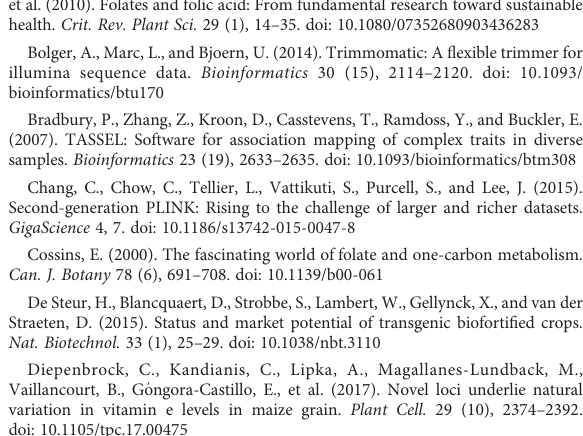
SUPPLEMENTARY FIGURE 5 Amino acid sequence alignment of ZmFCL and its orthologs in various species. Zm0001d13786 (B73), Zm0001d13786 (RC), SORBI_3001G181300, SETIT_038737mg, Os03g0582000, BGIOSGA013019, TraesCS1B02G321700 and HORVU.MOREX.r3.1HG0069460 were from fi eld corn, sweet corn, Sorghum bicolor , Setaria italic , O. japonica , O . indica , Triticum aestivum , and Hordeum vulgare , respectively. The numbers to the right indicate the amino acid sequence positions. Green helices represent a -helices, blue arrows indicate b -strands. The secondary structure was predicted by Phyre2 . The 228 th amino acid in the protein was highlighted with